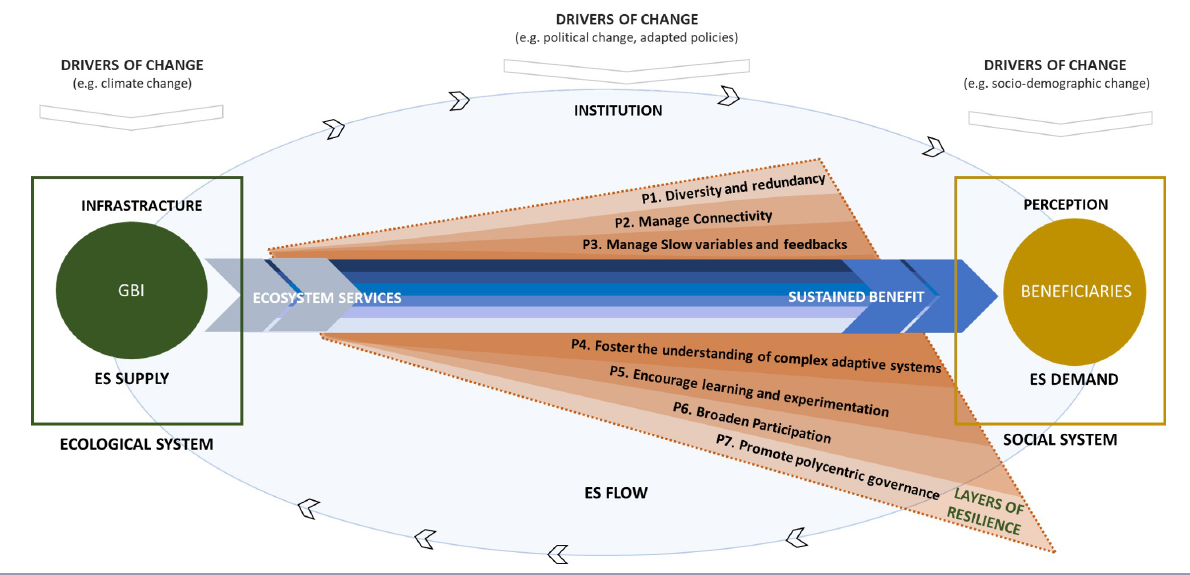
Fig. 1. The filters (perceptions, institutions, infrastructures) and ecosystem services (ES) resilience principles (P1 to P7) that affect the capacity of urban green and blue infrastructure (GBI) to produce ES and unlock the flow of benefits, under different drivers of changes. The study framework is built on Biggs et al. (2012) and Andersson et al. (2019), using the ES resilience principles and filters as pathways for sustainable policy-making. Arrows from left to right suggest that policy-making might work through the systemic filters and resilience principles to ensure resilient ES flow and counteract drivers of change that undermine the uptake of GBI